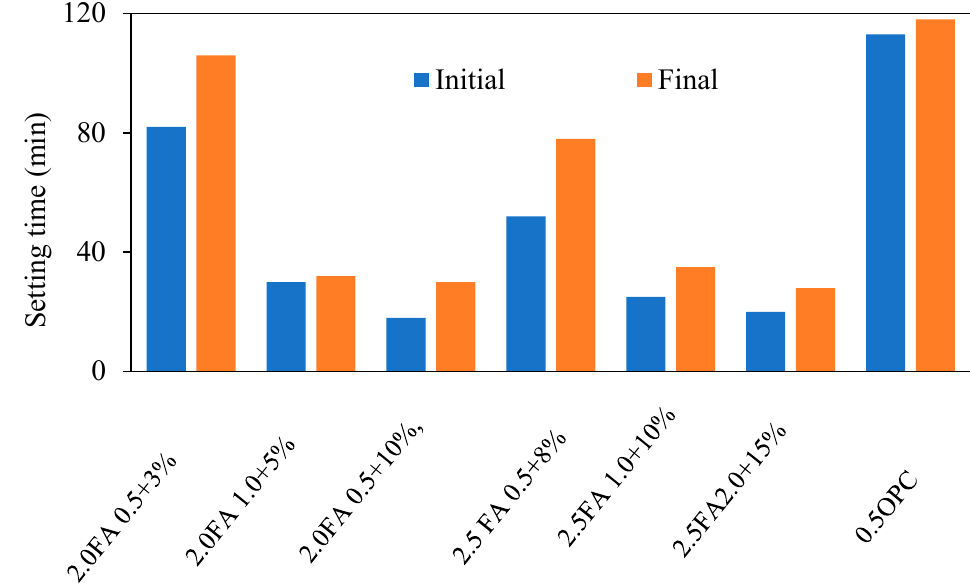
Figure 9. GPM setting times at different mixture proportions [42].